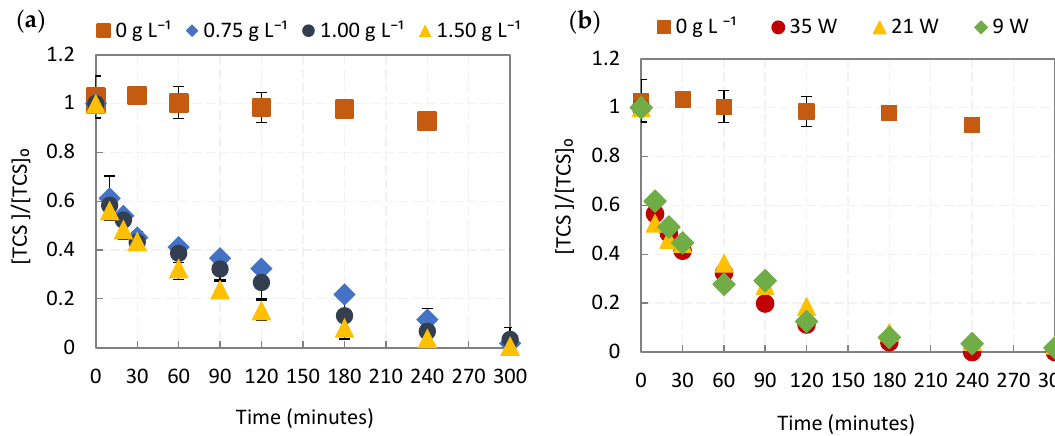
Figure 1. Influence of ( a ) TiO 2 loading working at 35 W and ( b ) light power working with 1.5 g L − 1 of TiO 2 .